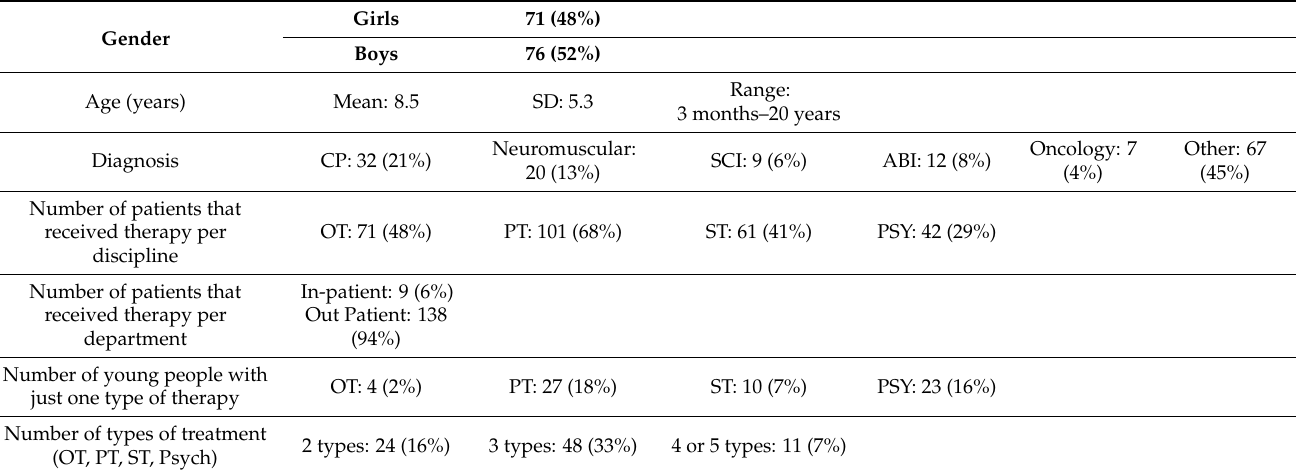
Table 1. Demographic information of participants.